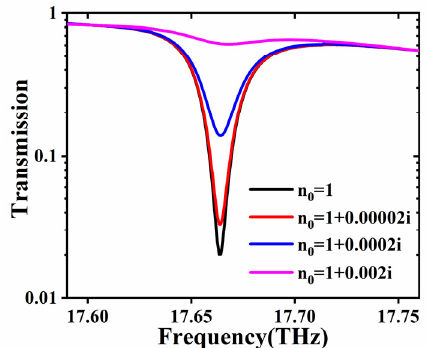
Figure 5. The transmission spectrum of the proposed structure when the background gas is N 2 O Here the imaginary parts of refractive index is changed from 0 to 0.002. Following the scaling law of electromagnetic theory, the geometry of the structure shown in Figure 1 has been scaling down to nearly 80%, noted that the operation frequency is 17.664 THz corresponding to the absorption peak of N 2 O molecule, here the incident angle is assumed to be 60°. Table 1. Comparison of the recently reported THz gas sensors.